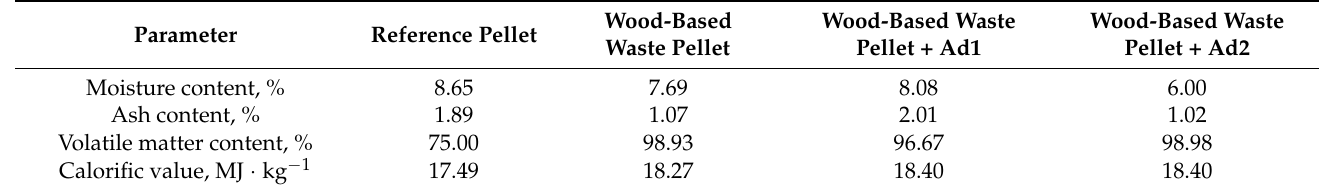
Table 2. Outcomes from biofuels’ technical analysis.